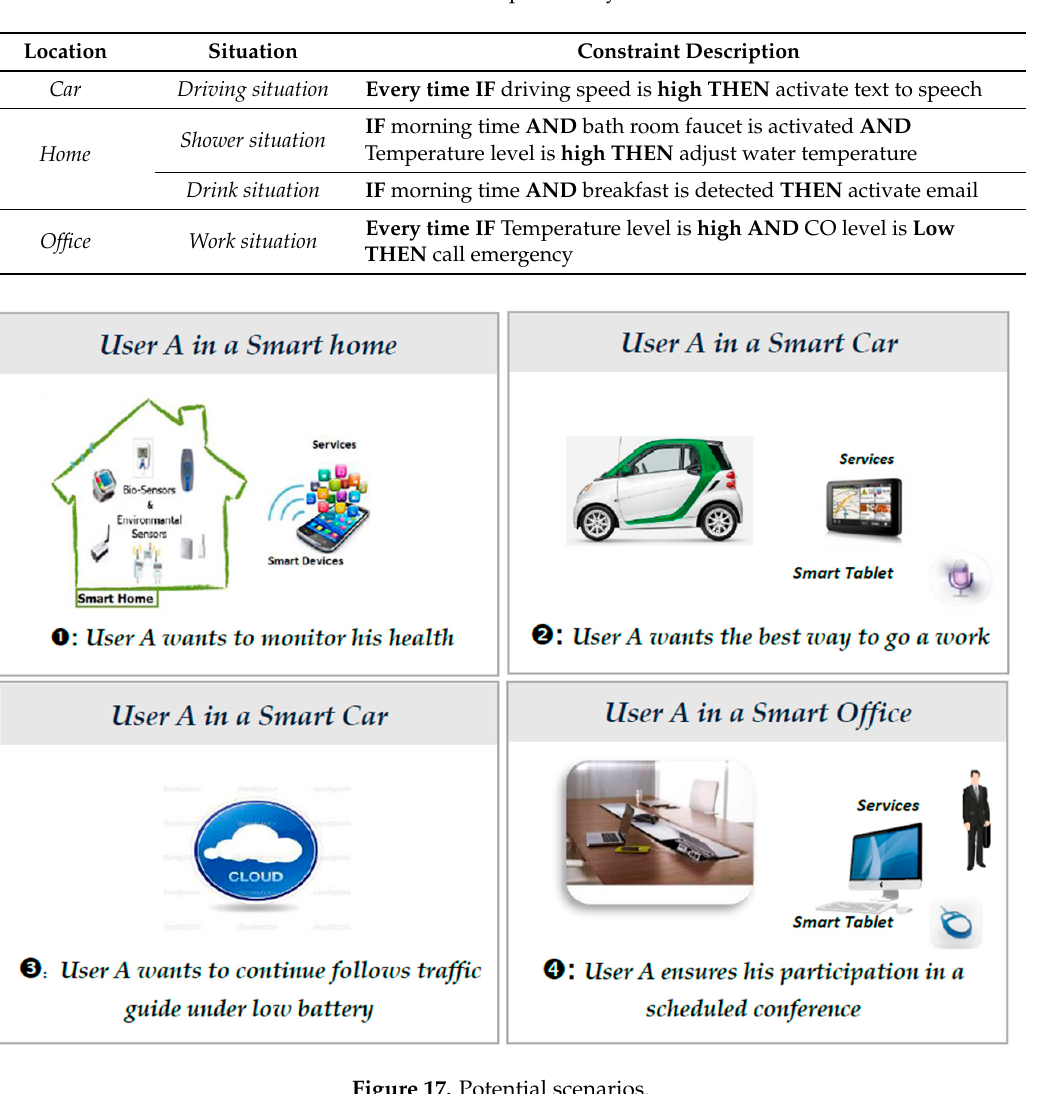
Table 4. Constraints specified by the developer.